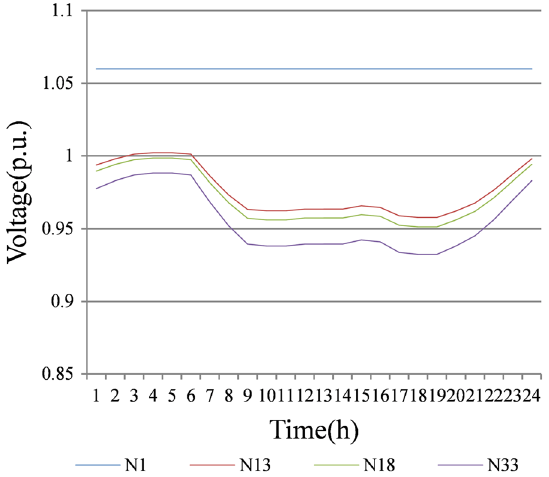
Fig. 6 Voltage profile after regulating by OLTC